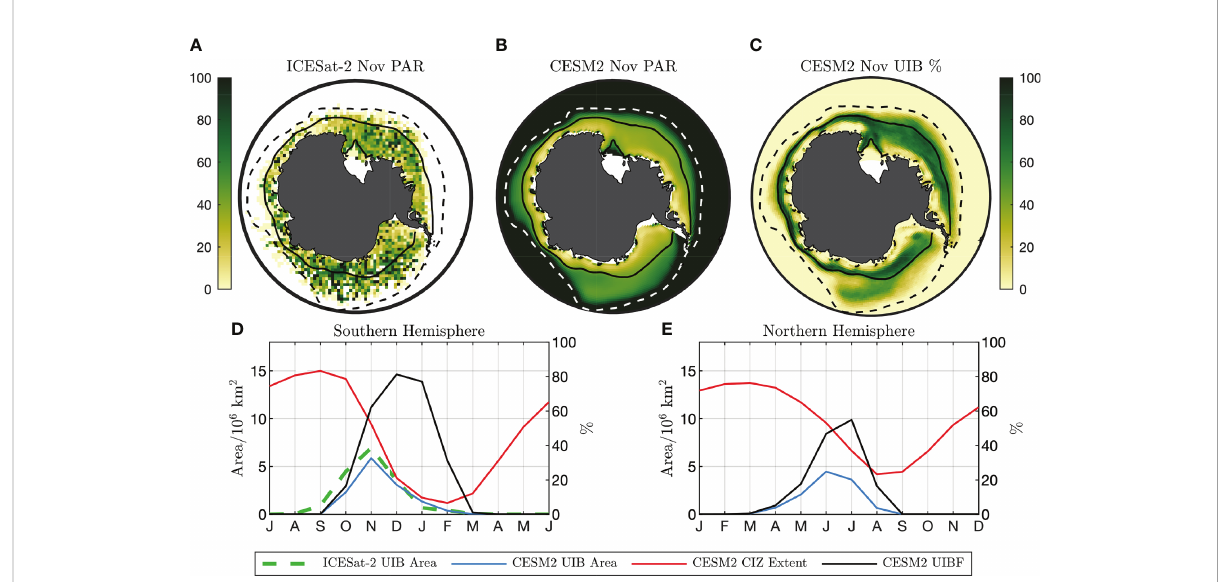
FIGURE 3 Light fi eld and UIB potential under Southern Ocean sea ice (A) 2018 – 2020 November surface PAR ( m mol photons/m 2 /s) estimate from ICESat- 2. (B) CESM2 climatological PAR from preindustrial simulation. Solid lines in (A, B) are CESM2 climatological CIZ (concentration above 80%). Dashed lines are climatological SIE (concentration above 15%). (C) CESM2 November UIB%. (D, left axis) Seasonal cycle of CESM2 (red) CIZ extent and (blue) UIB extent. The dashed green line is the UIB area from ICESat-2. ( D , right axis) CESM2 UIBF. (E) As in (D) , but for the Northern Hemisphere. Axes in (D) and (E) are offset by 6